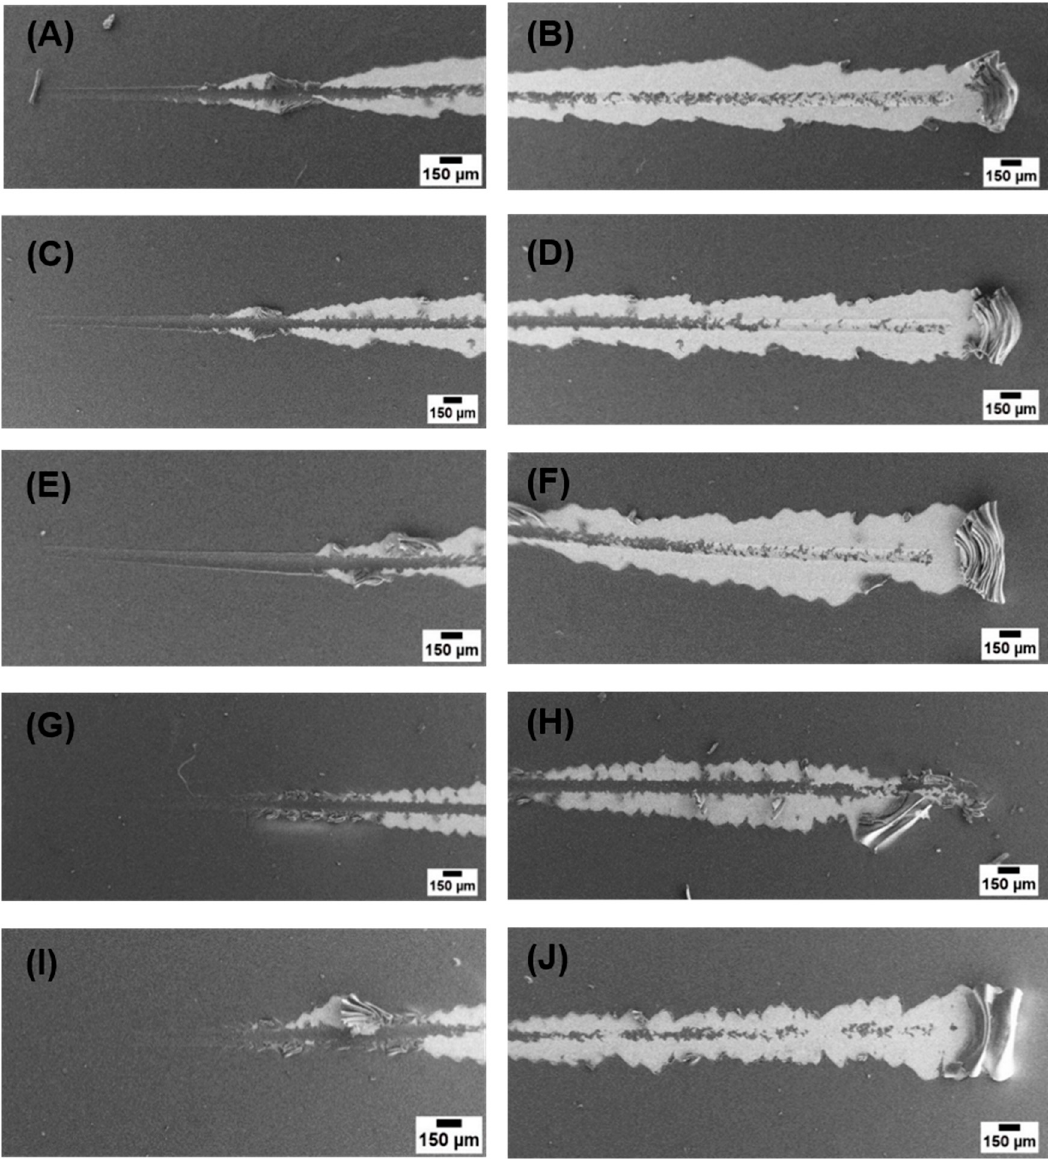
Figure 6. SEM images of sctratchs on coatings at lower and higher loads ( A , B ) CS, ( C , D ) Cu(II)–CS1, ( E , F ) Cu(II)–CS2, ( G , H ) Cu(II)–CS3, and ( I , J ) Cu(II)–CS4 coatings.